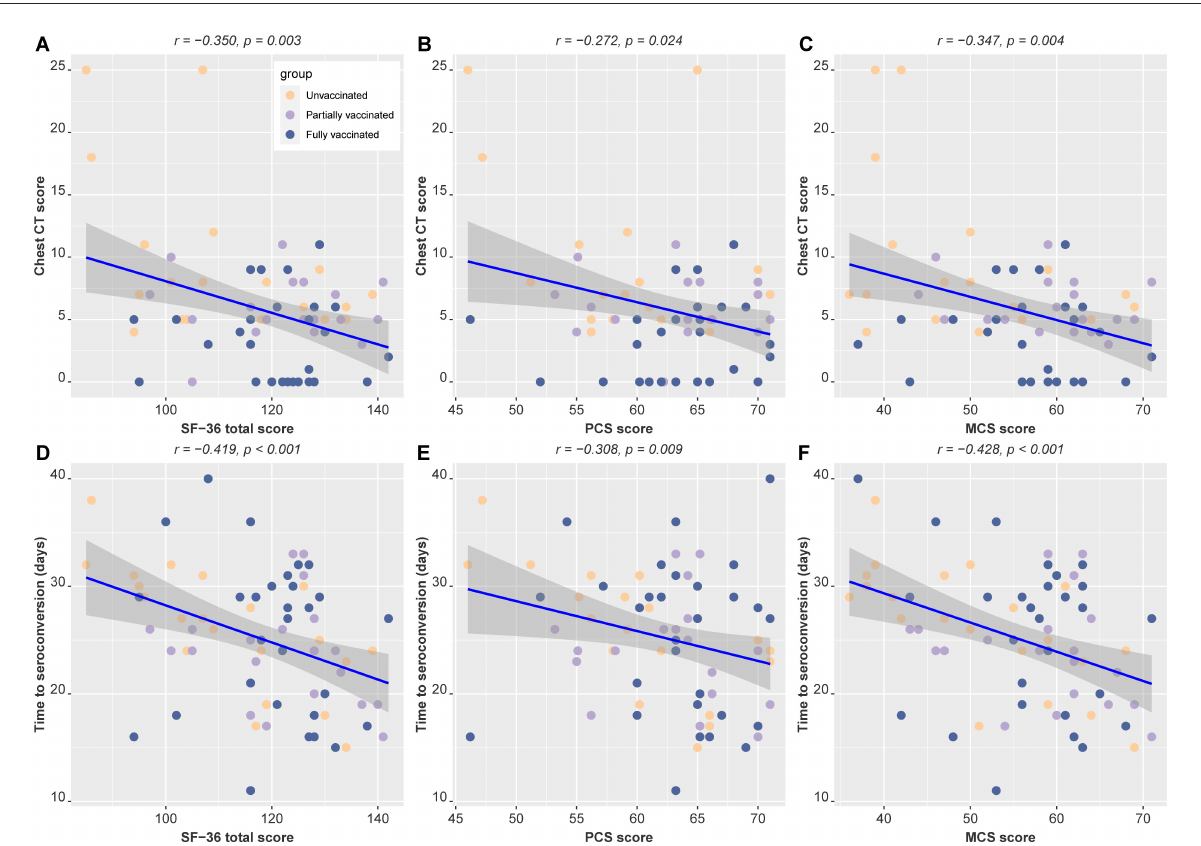
FIGURE2 Partial correlation analyses of quality of life with the chest CT score and time to seroconversion, with age, sex and education as covariables. The color of point represents vaccination status. The regression line for all subjects (blue line) and upper and lower 95% CIs (gray shades) are shown. (A–C) Partial correlation analysis between chest CT scores and SF-36 total score, PCS score, and MCS score. (D–F) Partial correlation analysis between seroconversion time and SF-36 total score, PCS score, and MCS score. PCS, physical component summary; MCS, mental component